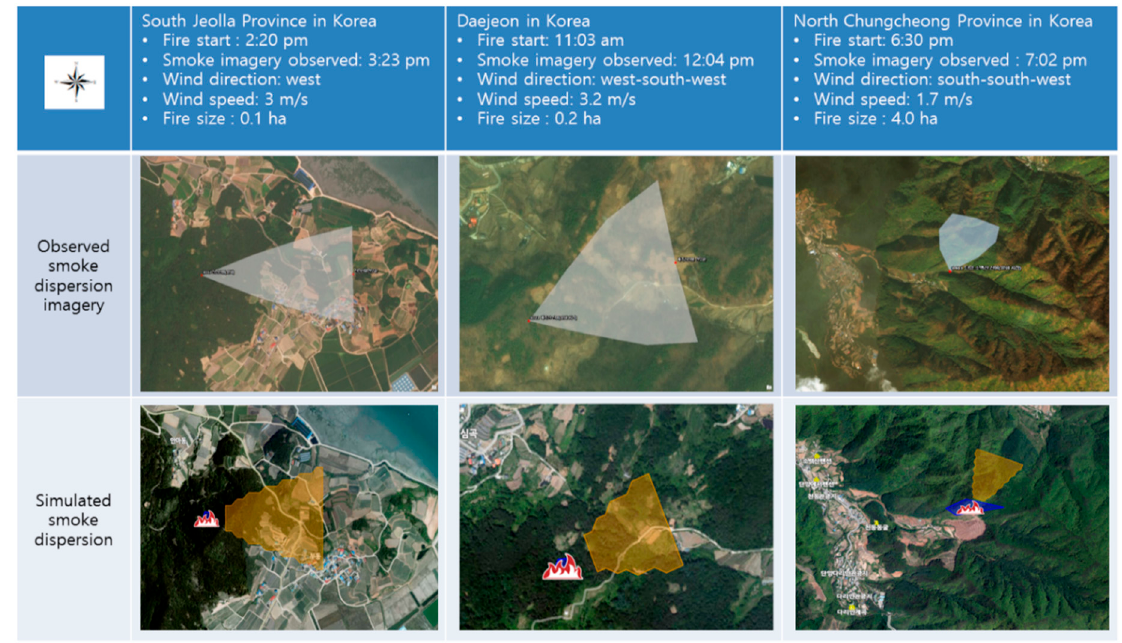
Figure 5. Comparison of smoke dispersion predictions with observed surface smoke plumes from real forest fires in Korea.